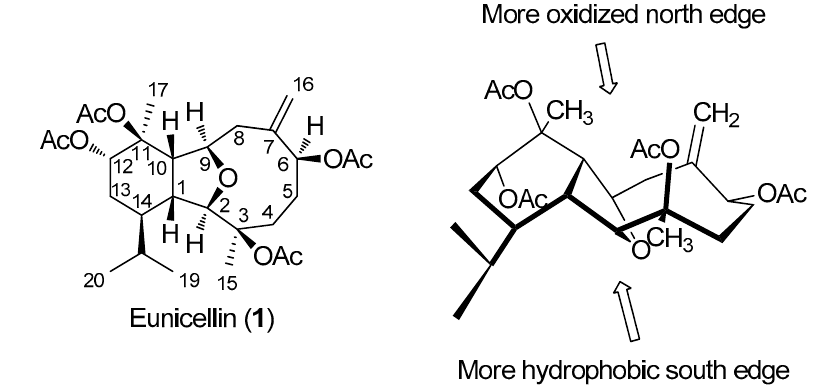
Figure 3. Eunicellin ( 1 ).